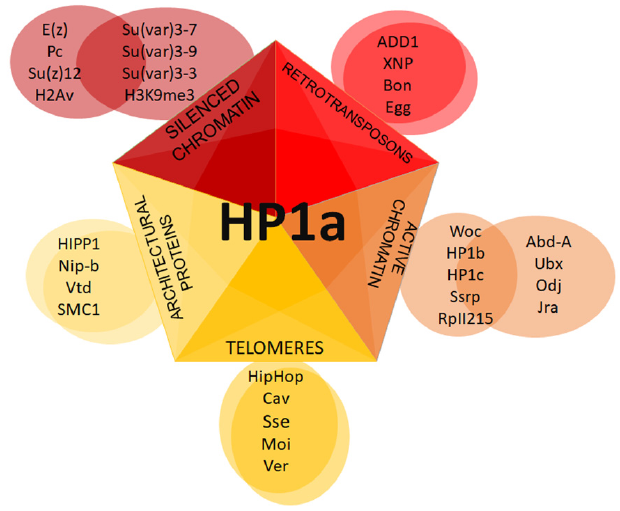
Figure 7. Putative HP1a complexes at different chromatin regions. Schematic representation of distinct complexes formed with HP1a.